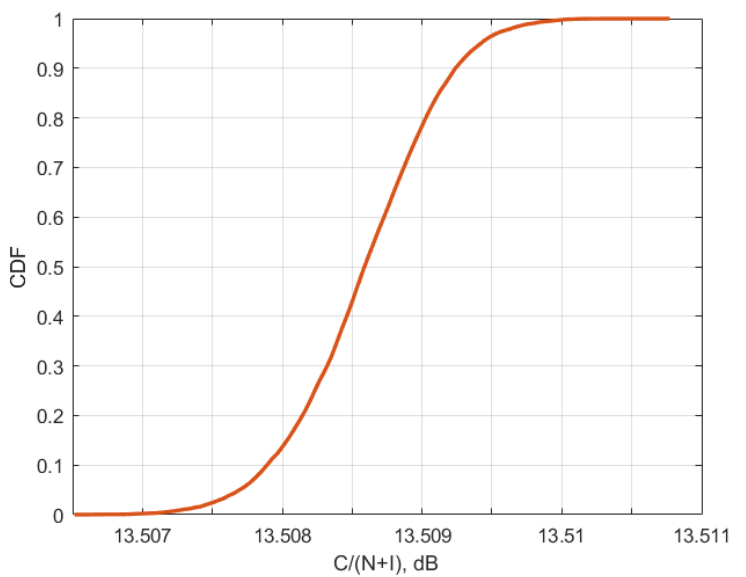
Figure 11. Cumulative distribution function of C/(N+I) for Express 140E for 6/4 GHz.